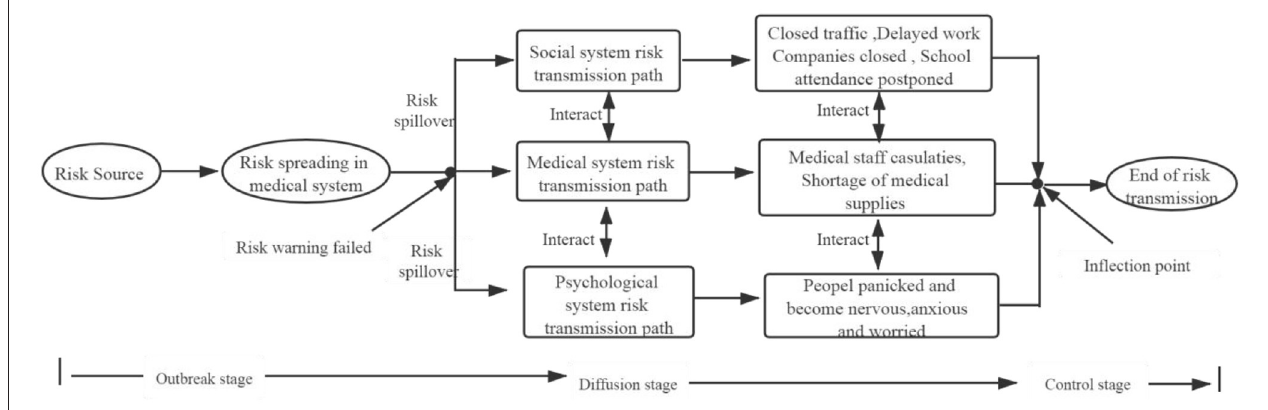
FIGURE 2 | Risk transmission mechanism model of sudden infectious epidemics.